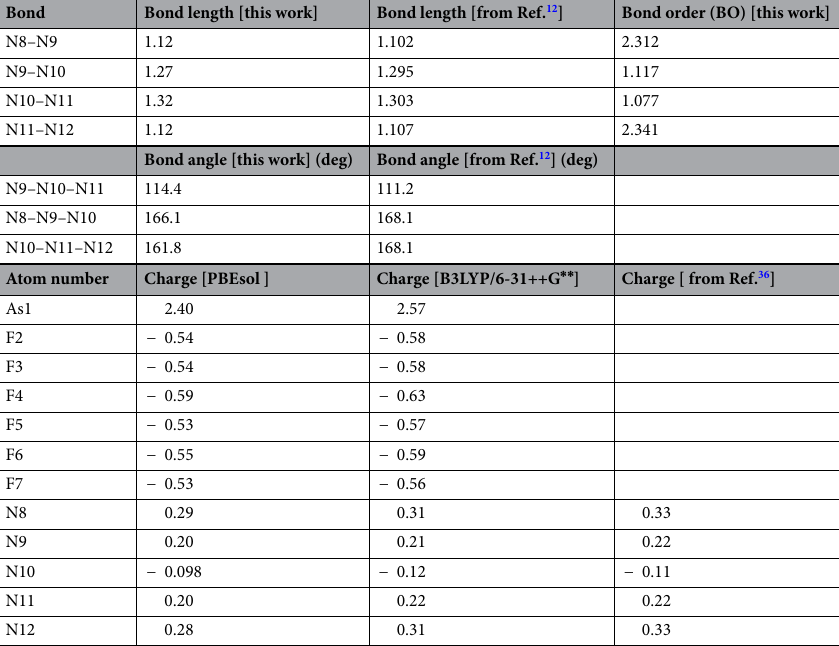
+ N 5 AsF 6 5 between the + 5 salt known from the work of Vij et al 12 . The natural charge + 5 in the work of